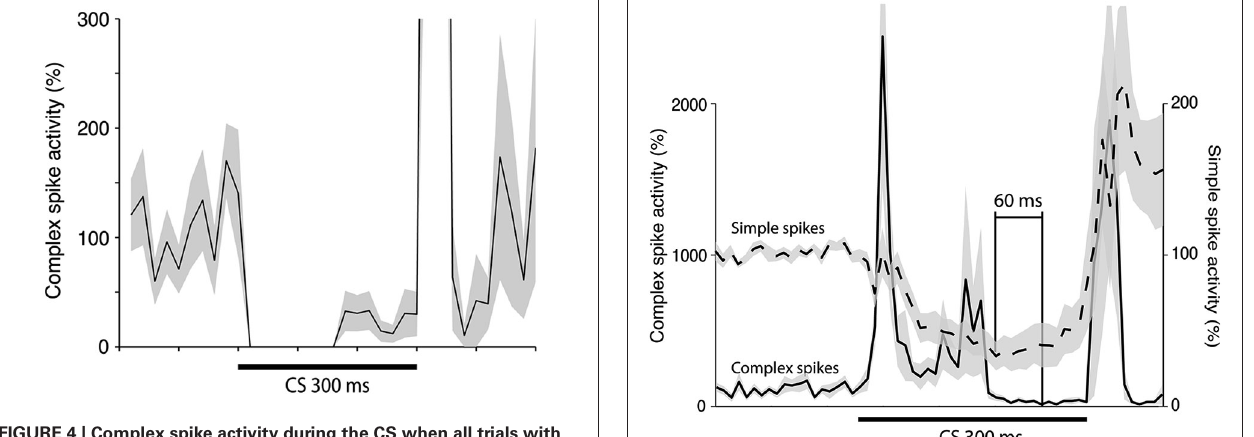
FIGURE 4 | Complex spike activity during the CS when all trials with CS facilitated complex spikes has been excluded. Mean ± SEM of relative complex spike activity in 11 cells either at the end of acquisition ( n = 7), or in the beginning of extinction ( n = 4). One cell was excluded from this analysis because it displayed CS facilitated complex spikes on a high proportion of the trials.